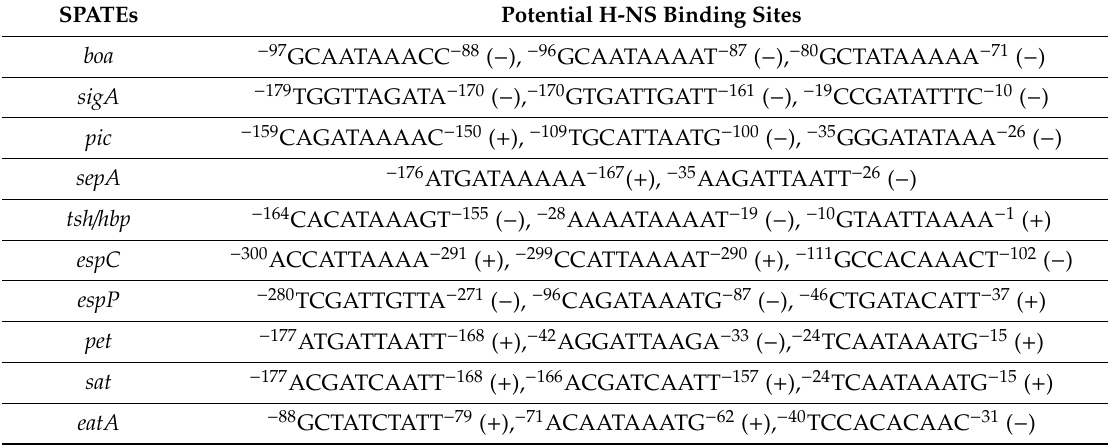
Table 2. The potential H-NS binding sites on the promoter region of SPATEs as predicted by Virtual Footprint Software a